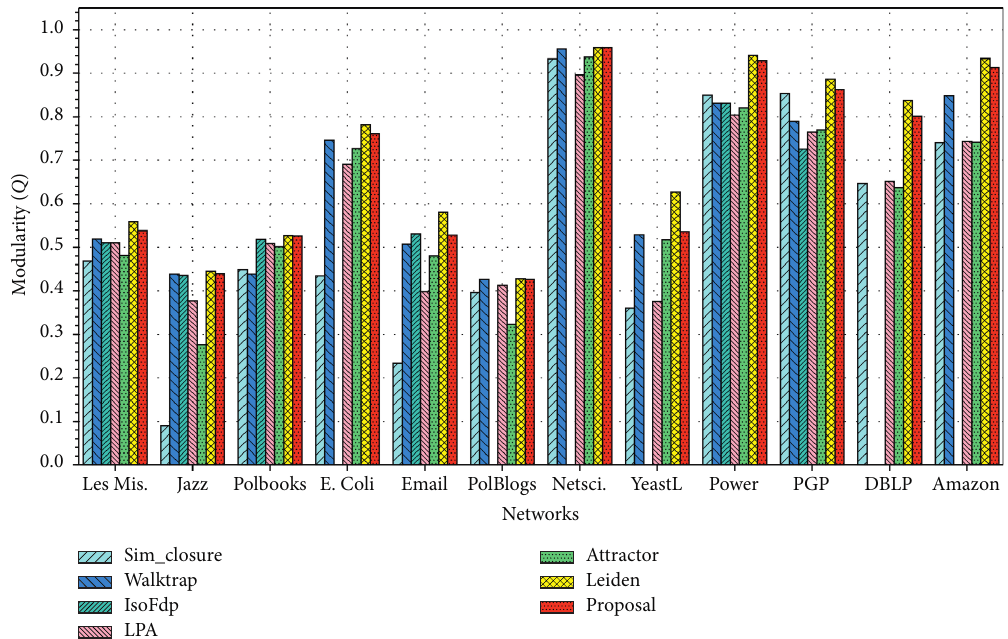
Figure 10: The bar chart of the modularity obtained by comparison algorithms and the proposed Table 1 in the manuscript. The real-world data supporting